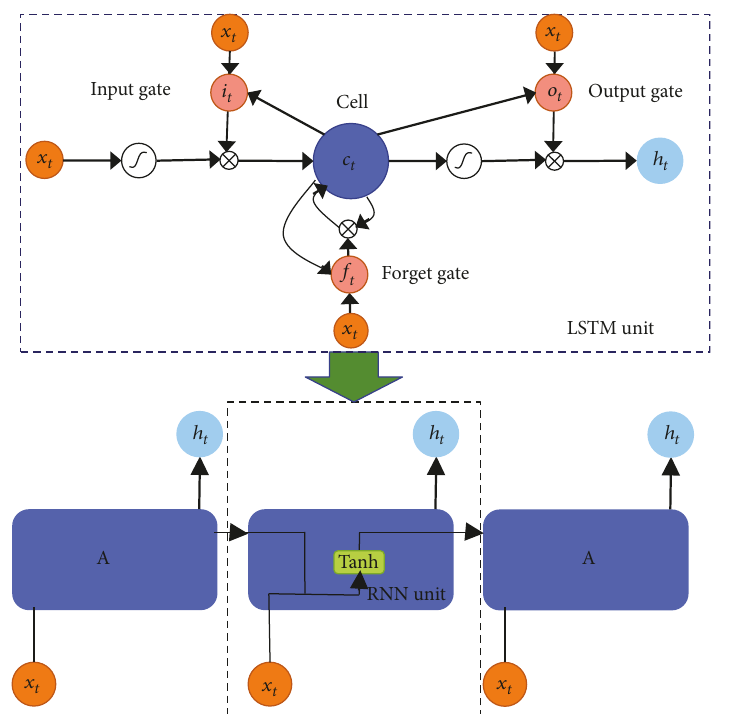
Figure 8: LSTM optimization of a recurrent neural network unit. Table 5: The parameter of RNN-LSTM